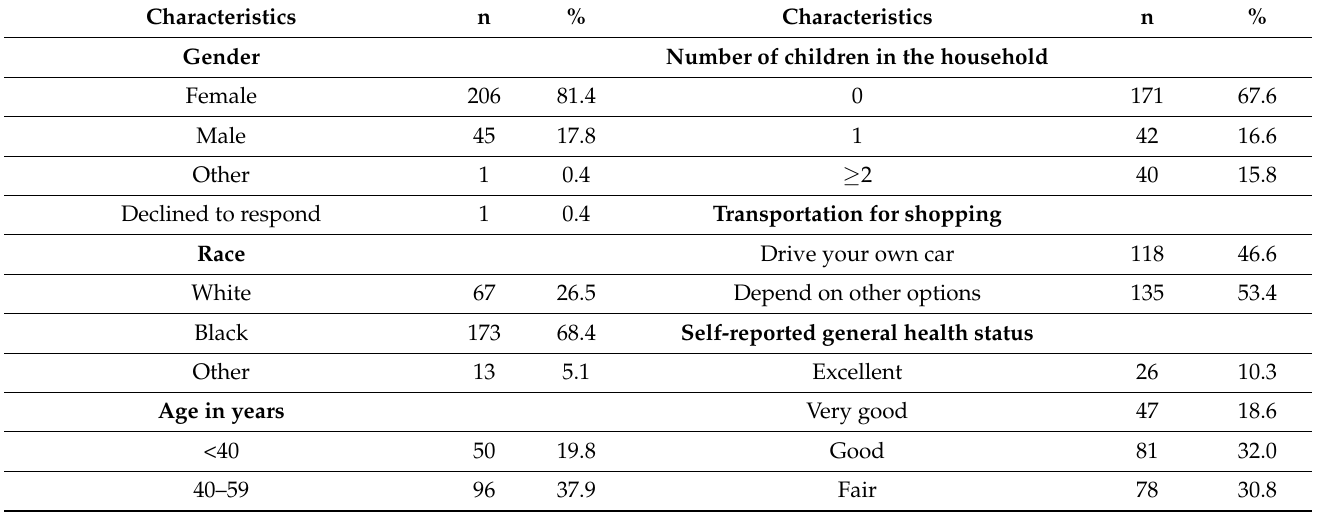
Table 1. Characteristics of the cross-sectional survey participants: 253 SNAP recipients from Cleve- land and Akron, Ohio, with access to nutrition incentive programming near their home in 2019.